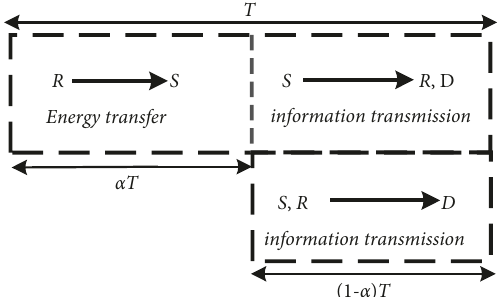
Figure 2: ECS-HTCARQ protocol transmission process in in- terference